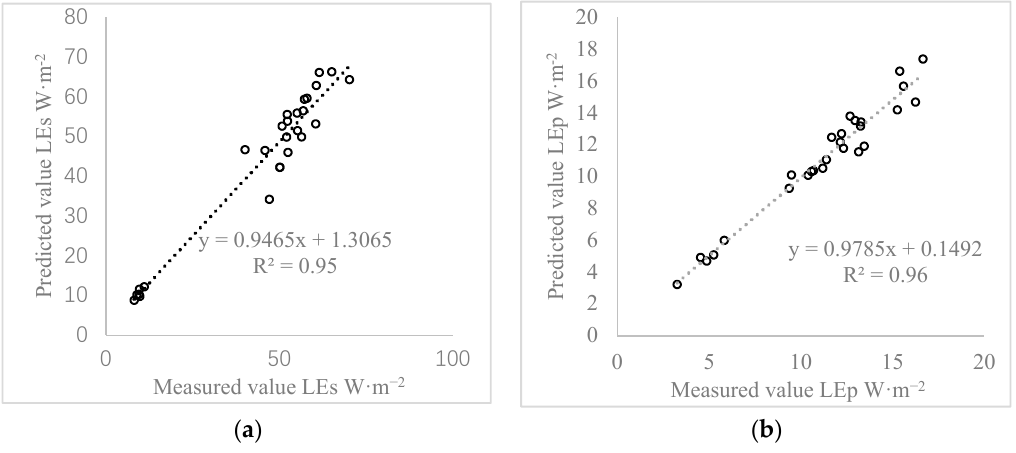
Figure 5. ( a ) The linear relationship between the predicted and measured values of LE s ; ( b ) The linear relationship between the predicted and measured values of LE p .